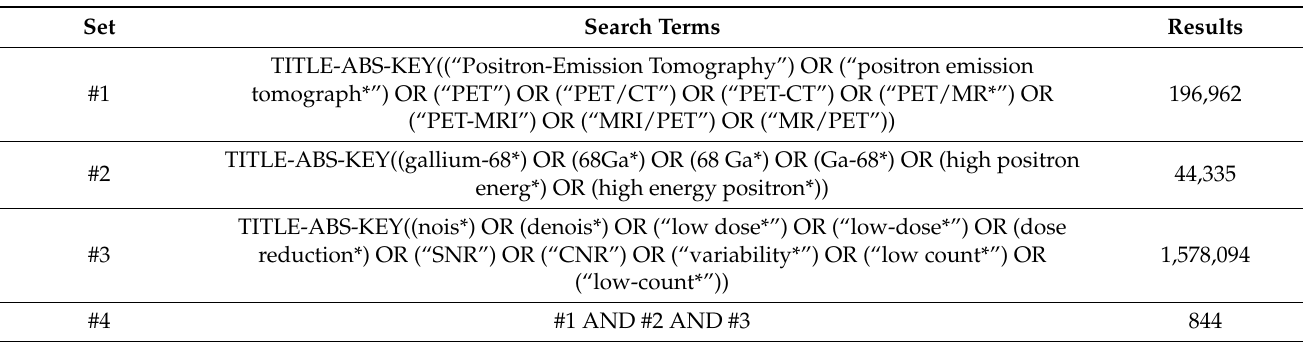
Table A4. The search query for noise reduction techniques in Scopus. In the column “Results”, the numbers of records are provided for the corresponding search terms from between January 2010 until 1 August